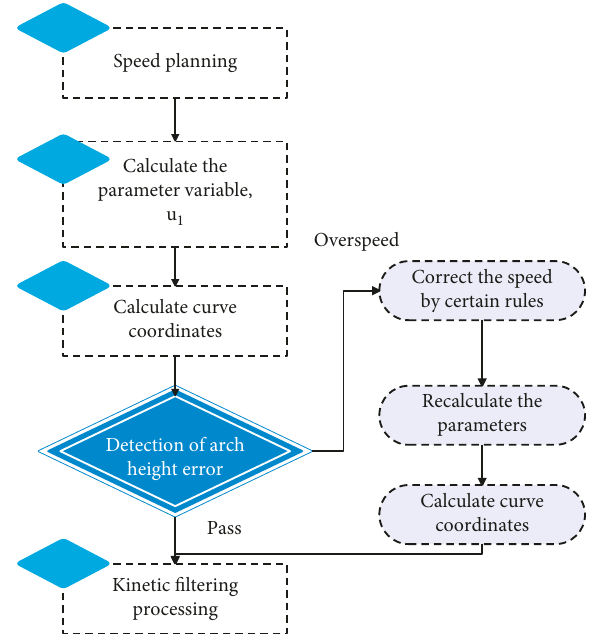
Figure 1: Structure diagram of NURBS interpolation